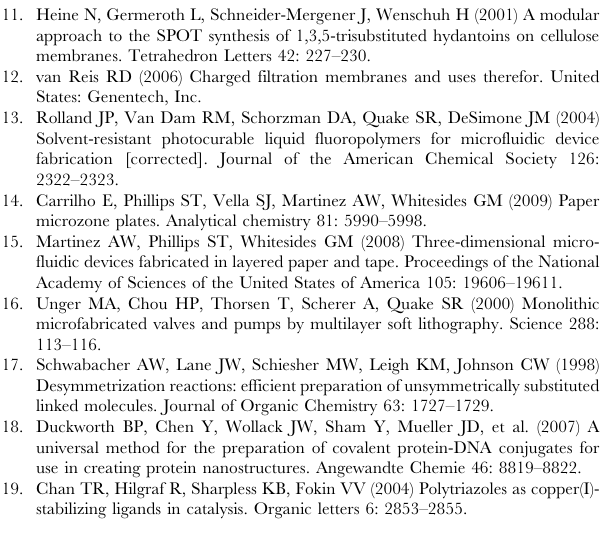
Figure S11 Circuit diagram for Stamp PLC. (TIFF) Table S1 Masses of peptoid-DNA conjugates in Figure 2b following digestion with nuclease